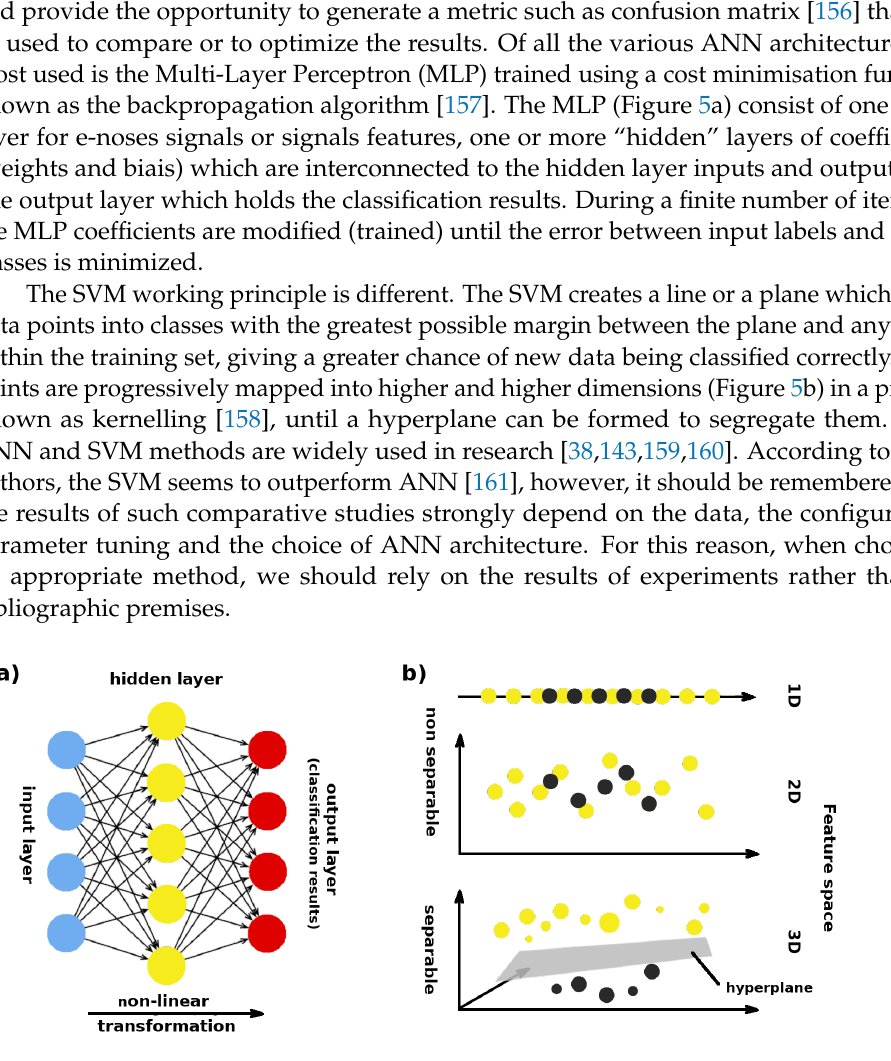
Figure 5. Simplified visualisation of: ( a ) multi layer perceptron, ( b ) support vector machine